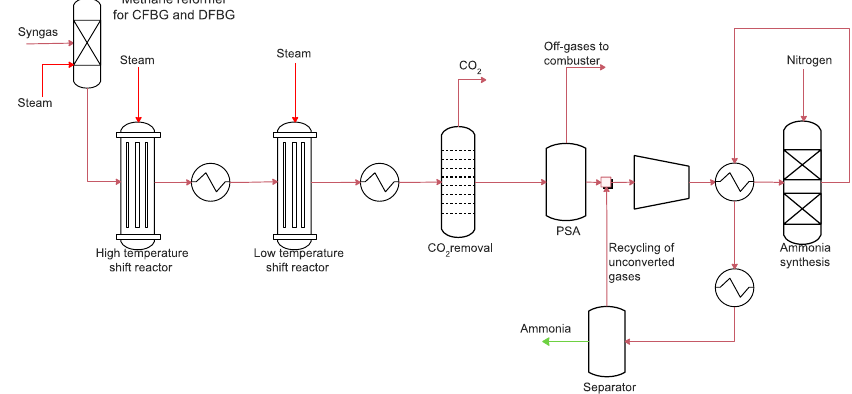
Figure 8. Process flow diagram of ammonia synthesis from syngas produced from waste gasification.